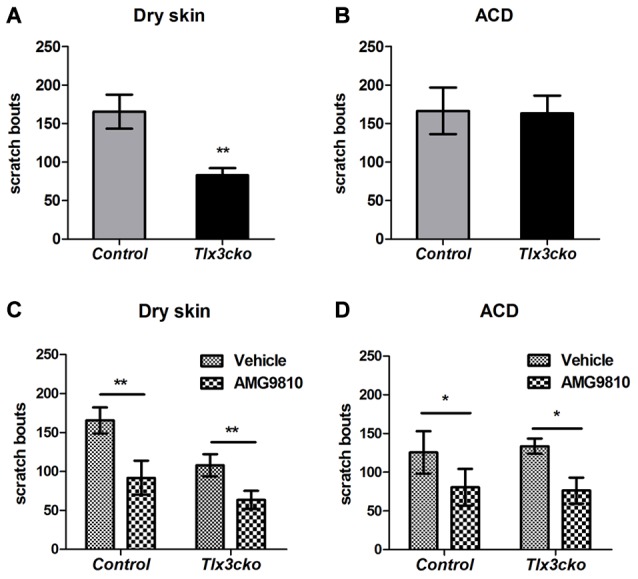
Impaired dry skin-induced chronic itch in Tlx3cko mice and the involvement of TRPV1 in chronic itch. The dry skin and allergic contact dermatitis (ACD) models were used to assess the responses to chronic itch. (A) Impaired chronic itch induced by dry skin in Tlx3cko mice (control, 165 ± 22, n = 14; Tlx3cko, 83 ± 9, n = 9; p = 0.0087). (B) Similar response to chronic itch induced by ACD in Tlx3cko and control mice (control, 166 ± 30, n = 7; Tlx3cko, 163 ± 23, n = 7; p = 0.9384). (C) TRPV1 antagonist AMG9810 significantly reduced the spontaneous scratching induced by dry skin in both Tlx3cko and control mice (control: vehicle 166 ± 17, n = 9 vs. AMG9810 92 ± 22, n = 9; p = 0.0028; Tlx3cko: vehicle 108 ± 12, n = 5 vs. AMG9810 63 ± 12, n = 5; p = 0.0031). (D) AMG9810 significantly alleviated chronic itch induced by ACD (control: vehicle 125 ± 27, n = 7 vs. AMG9810 80 ± 23, n = 7; p = 0.0305; Tlx3cko: vehicle 133 ± 10, n = 7 vs. AMG9810 76 ± 17, n = 7; p = 0.0271). *,** Indicates p < 0.05, p < 0.01, respectively.